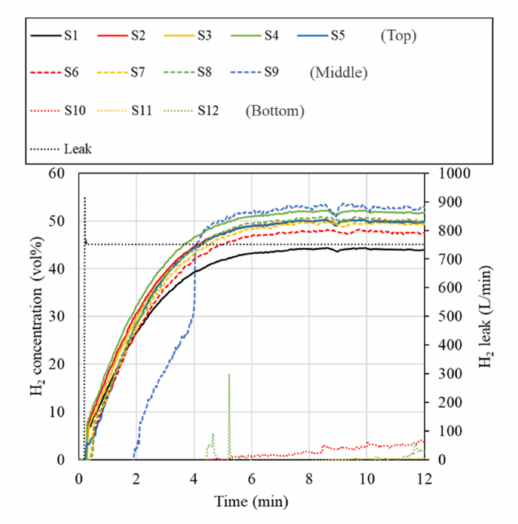
Figure 2. Hydrogen concentration variation by leak (Case 1: hydrogen supply pressure 3 kPa,